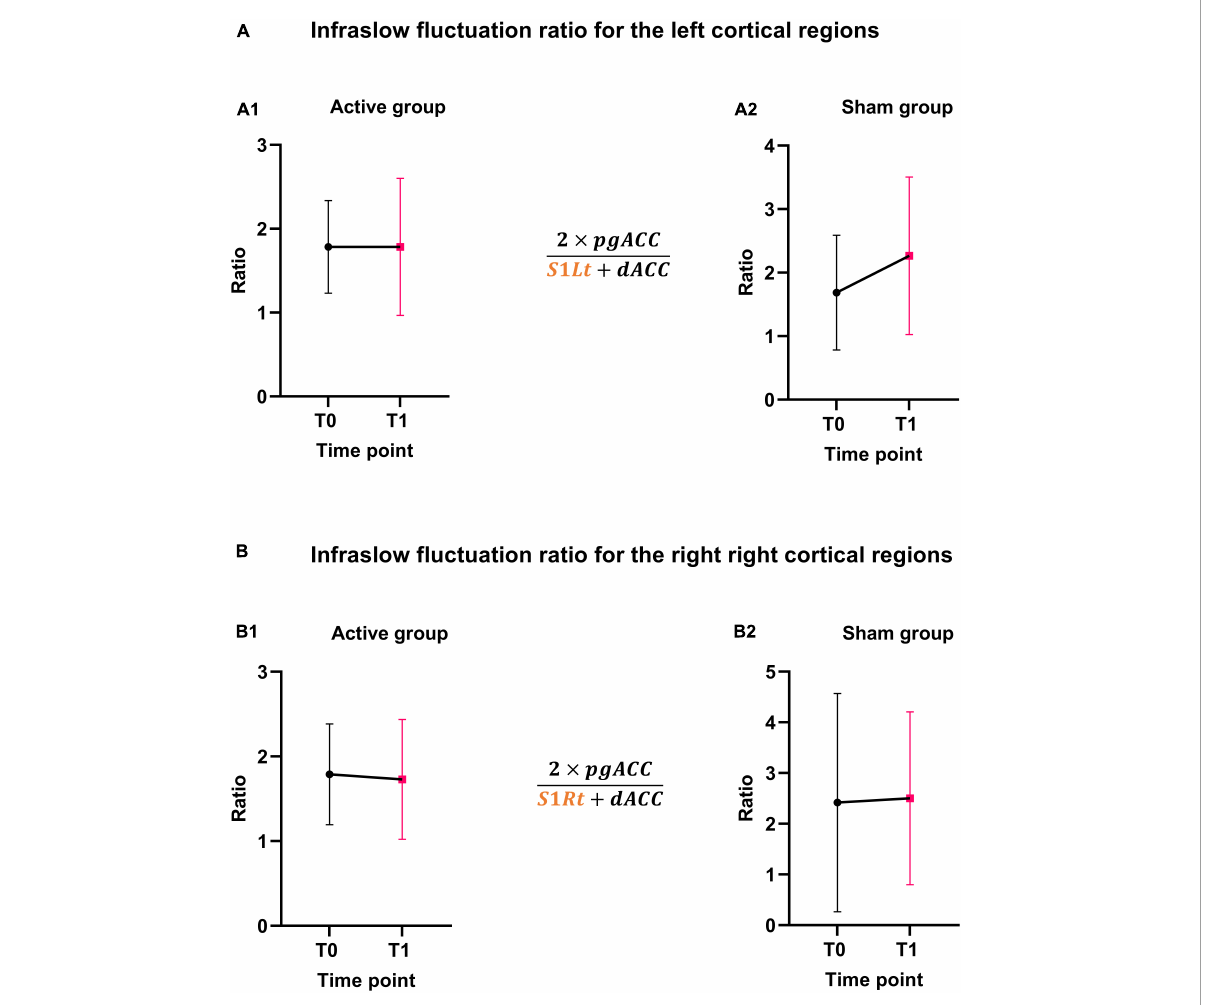
FIGURE8 ISF ratio changes. (A,B) Shows the ISF-NF ratio changes before and after NF training for the active and sham groups for left and right cortical